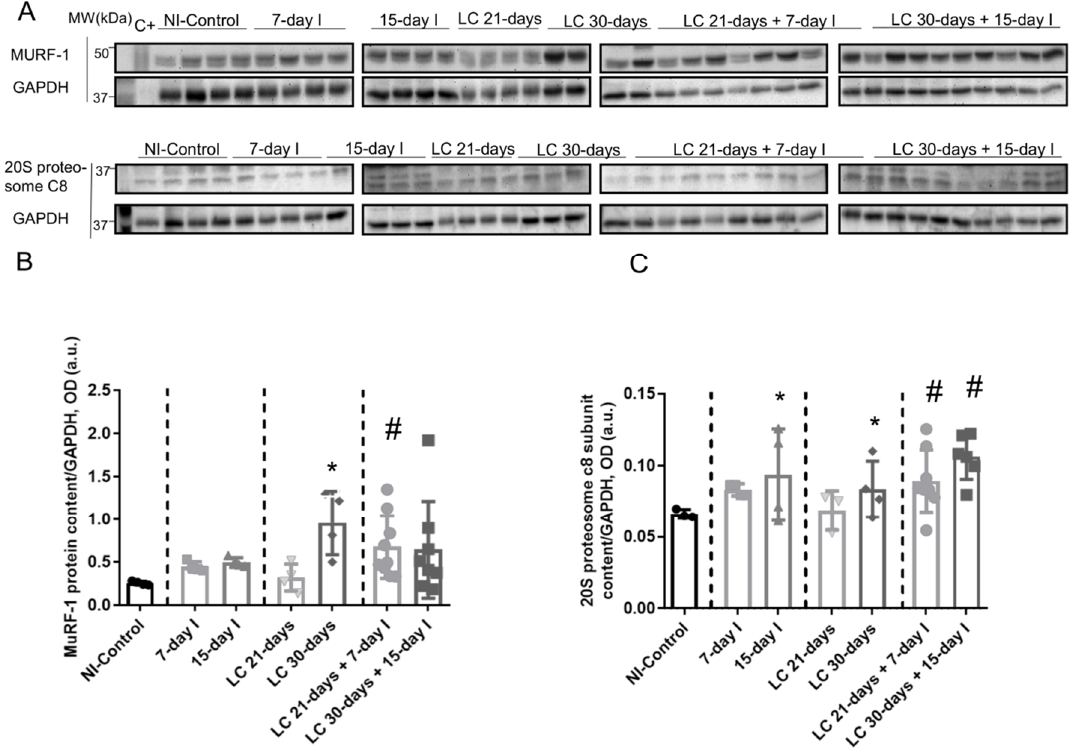
Figure 4. ( A ) Representative immunoblots of MuRF-1, 20S proteasome alpha subunit C8, and GAPDH proteins in the gastrocnemius muscle of all study groups of mice. ( B ) Mean values and standard deviation of MuRF-1 protein content in the gastrocnemius muscle of the different study groups of mice, as measured by optical densities in arbitrary units (OD, a.u.). Statistical significance is represented as follows: * p < 0.05 between 7-day I, 15-day I, LC 21-days, LC 30-days animals, and the NI-control mice; # p < 0.05 between any group of LC-cachexia mice and their respective group of mice bearing the two conditions (LC-cachexia and unloading). ( C ) Mean values and standard deviation of 20S proteasome c8 subunit protein content in the gastrocnemius muscle of the different study groups of mice, as measured by optical densities in arbitrary units (OD, a.u.). Statistical significance is represented as follows: * p < 0.05 between 7-day I, 15-day I, LC 21-days, LC 30-days animals, and the NI-control mice; # p < 0.05 between any group of LC-cachexia mice and their respective group of mice bearing the two conditions (LC-cachexia and unloading). Definition of abbreviations: MuRF-1, muscle RING-finger protein-1; GAPDH, glyceraldehyde-3-phosphate dehydrogenase; MW, molecular weight; kDa, kilodalton; C+, positive control; NI, non-immobilized; I, immobilization; LC, lung cancer.